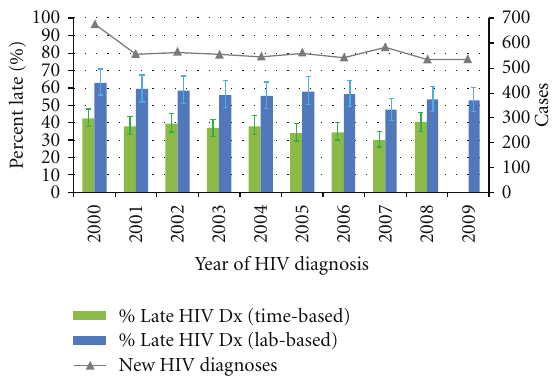
Figure 1: New HIV diagnoses and proportions that were diagnosed late, by year of HIV diagnosis, Washington State, 2000–2009.